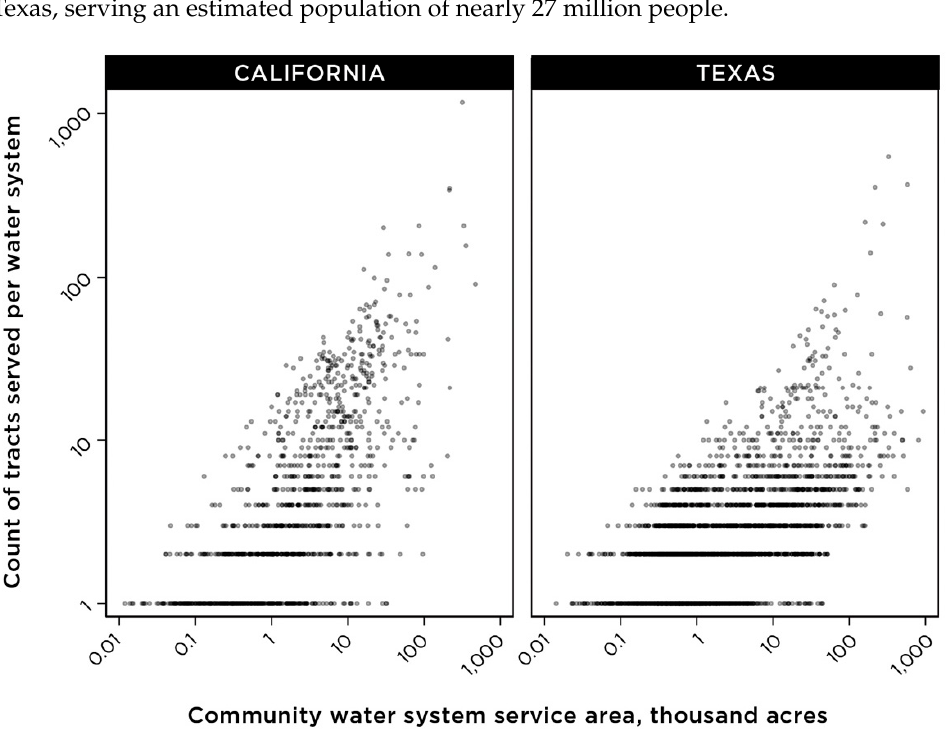
Figure 7. Number of unique census tracts that are partially or completely included in the service areas of community water systems in California and Texas. An acre, a unit of land measurement commonly used in the United States, corresponds to approximately 4047 m 2